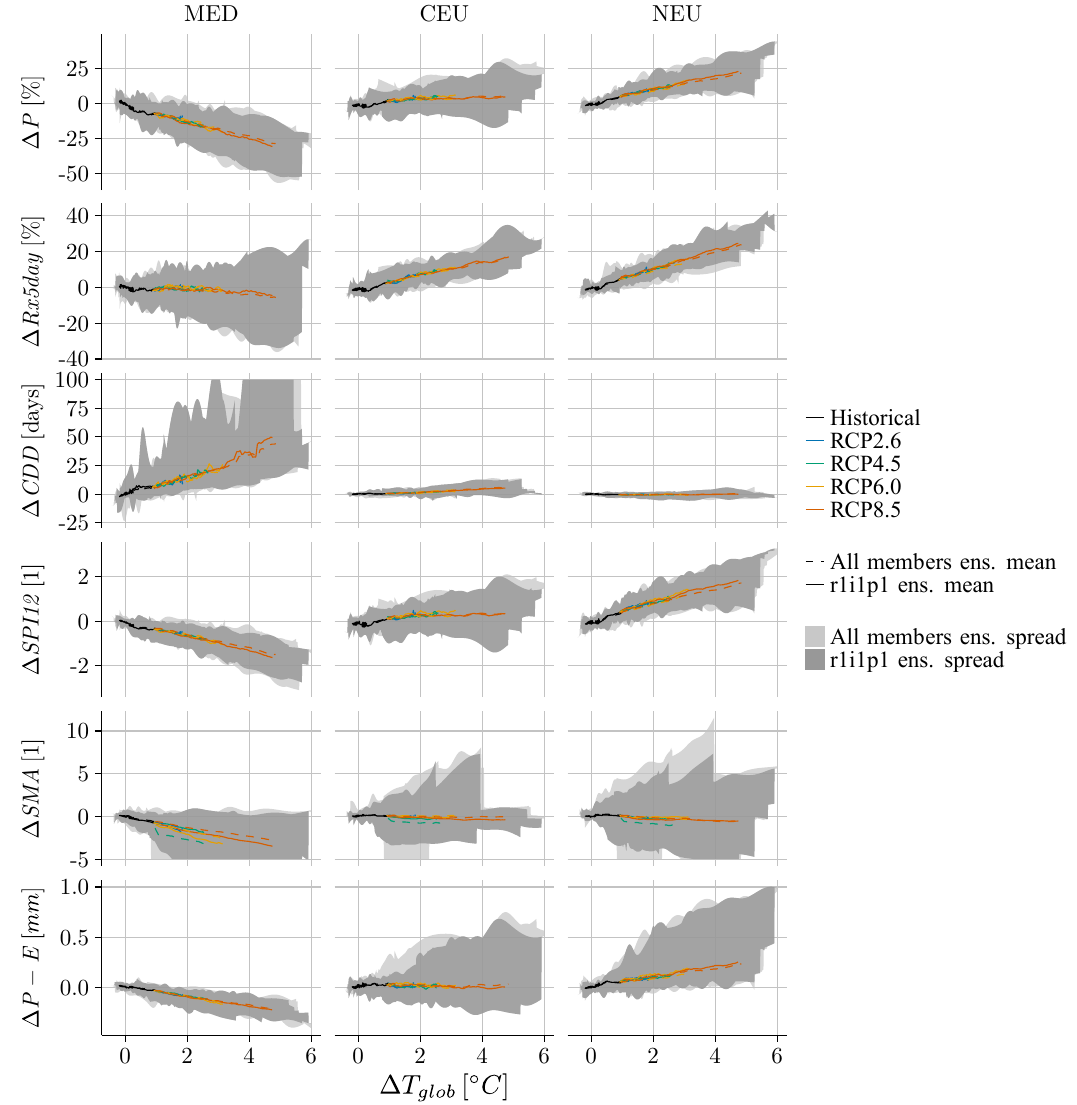
Figure 8. Functional relationships with global mean temperature for the indices (cid:49)P , (cid:49) Rx5day, (cid:49) CDD, (cid:49) SPI12, (cid:49) SMA, and (cid:49)P − E , averaged over the SREX regions MED, CEU, and NEU. Indices based on all CMIP5 ensemble members available per model (solid lines, dark shading) are compared with indices based on ensemble member r1i1p1 of each model (dashed lines, light shading). Values for (cid:49) CDD > 100 days and (cid:49) SMA < − 5 were cut off for